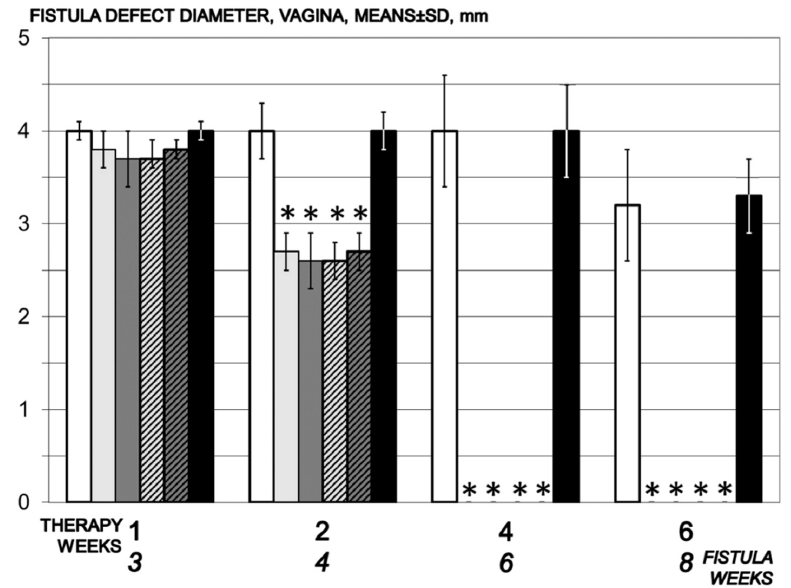
Figure 5. Vaginal defect diameter, mm, means ± SD, time line. Therapy regimens starting at the day